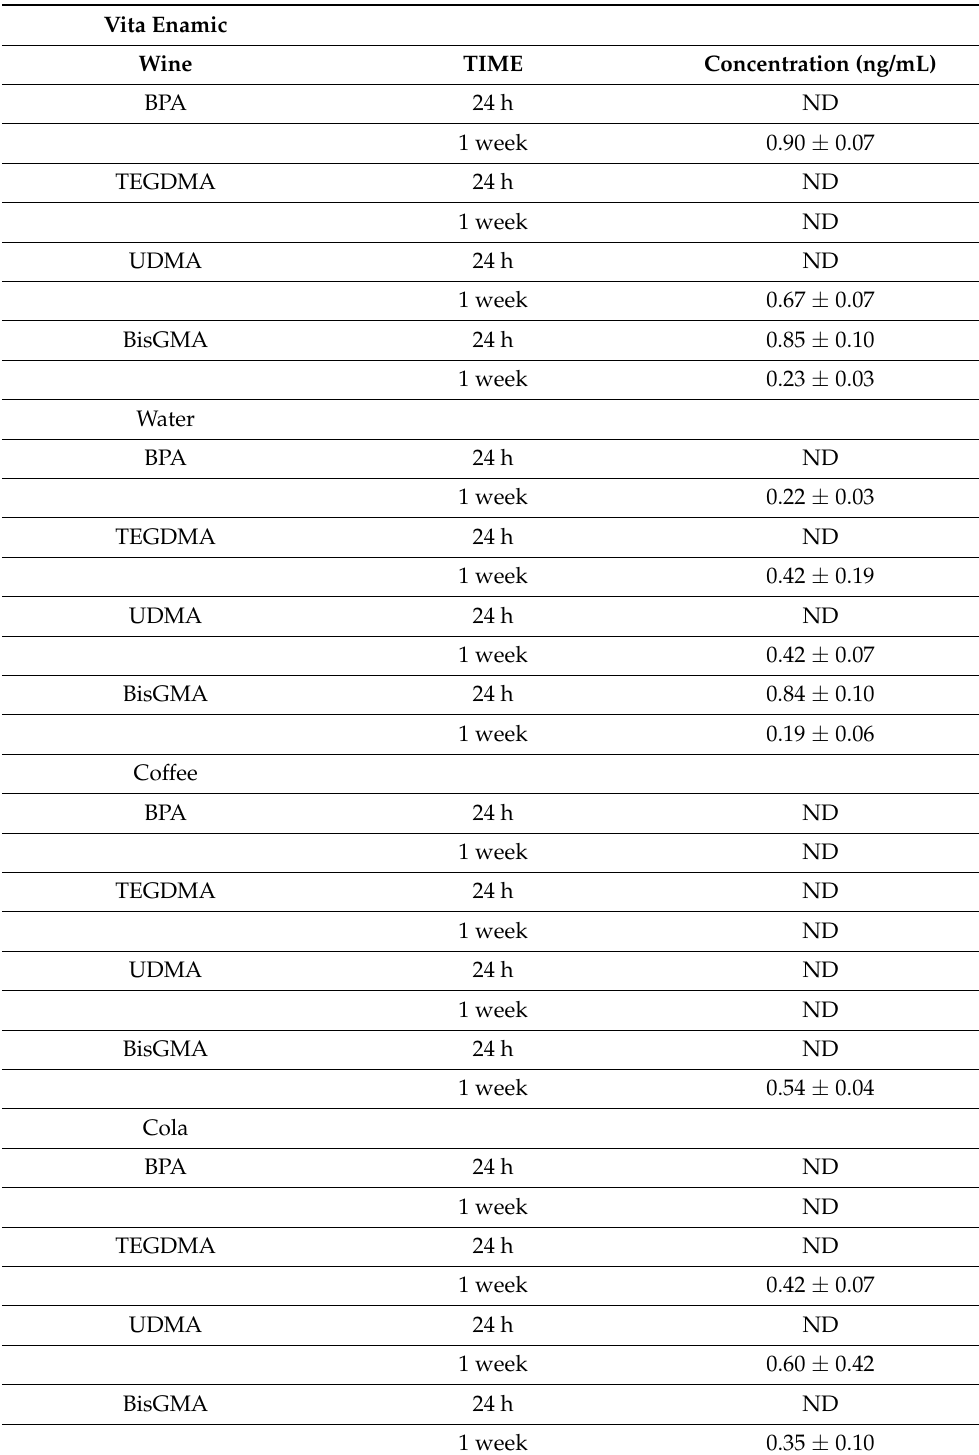
Table 3. Eluted impurities (Mean ± standard deviation, ng/mL) for Vita Enamic after incubation in all beverage solutions and each time